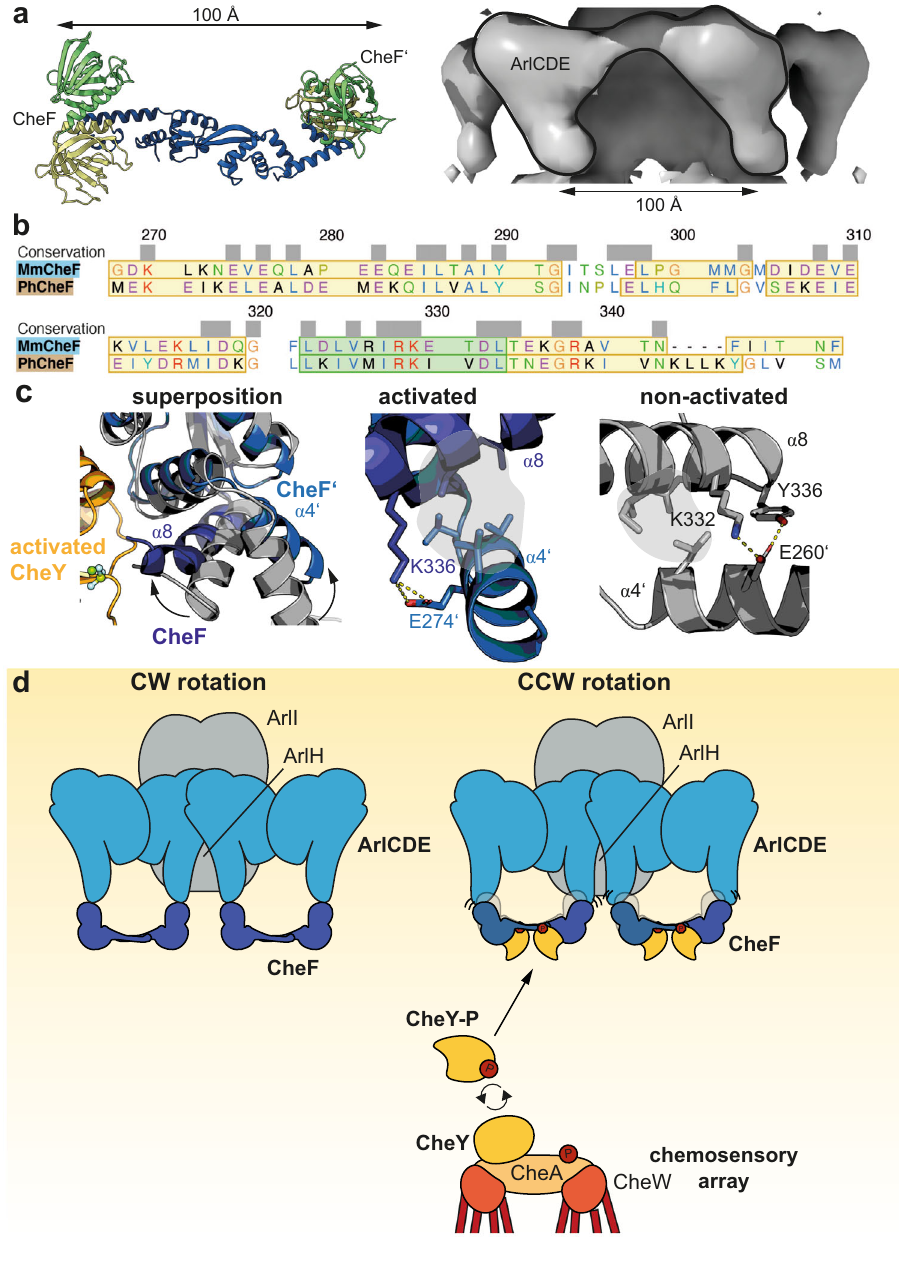
Fig. 6 Binding of CheY-P to CheF leads to conformational changes. a Distance between the PH-domains of the two CheF monomers and the “ legs ” of the ArlCDE-complex assigned density (EMD-3759) is ~100 Å. b Sequence alignment of the CTD ’ s of MmCheF and PhCheF. The actual secondary structure elements derived from the two structures are projected onto the amino acid sequence. Yellow boxes mark α -helices and green boxes indicate β -strands. Residues are colored according to the Clustal X coloring scheme that depends on the residue type and conservation pattern in the respective column. c Superposition of CheF alone (gray) and bound to activated CheY-P shows conformational changes of helix α 8 and subsequent movement of helix α 4 through polar and hydrophobic interactions. d Model of how rotational switching might occur upon binding of CheY-P to CheF. The twisted architecture combined with the conformational changes at CheF might be transmitted to the ArlCDE complex and lead to slight changes in the C-ring